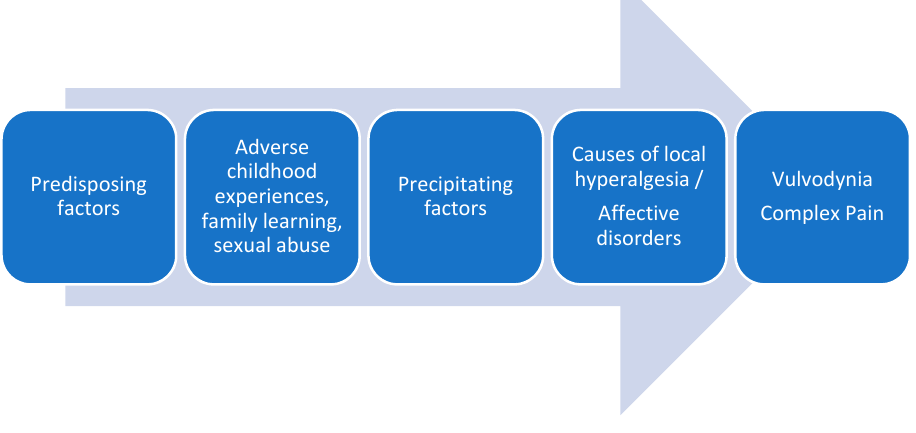
Figure 1. Factors involved in vulvodynia.